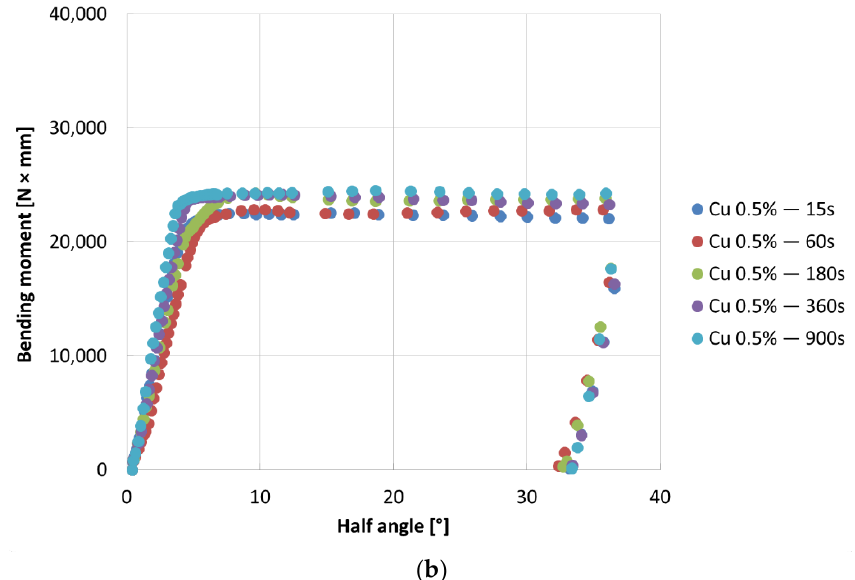
Figure 4. Bending tests results for specimens from: ( a ) Zn-Sn 3% bath, ( b ) Zn-Cu 0.5% bath.